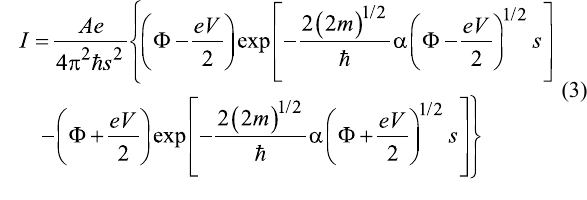
where A represents the contact area of the molecule with the gold surface (this value has been taken as 0.2 nm 2 in concor- dance with the surface pressure vs area per molecule isotherm at a surface pressure of 16 mN ∙ m − 1 ); V is the applied potential; s is the width of the tunneling barrier, which has been taken